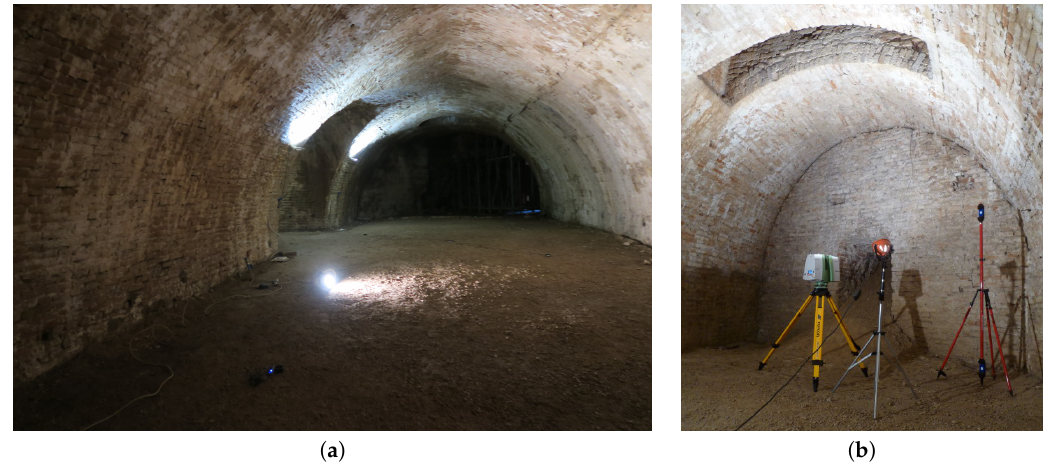
Figure 2. ( a) A section of the tunnel of the Impossible bastion. ( b ) Setup of the Leica ScanStation C10 over a traverse mark and target pole over the back